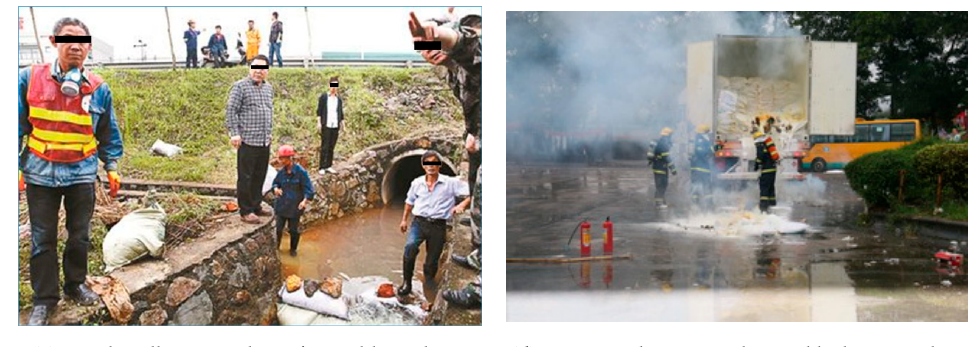
Figure 1. Hazardous materials transportation accidents.